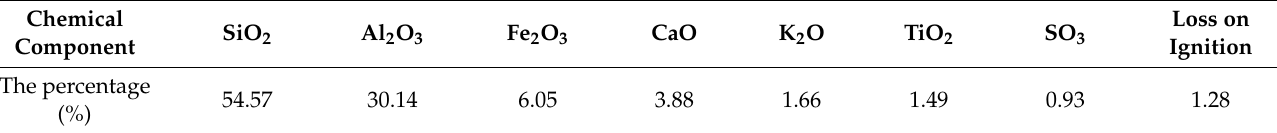
Table 1. The chemical properties of fly